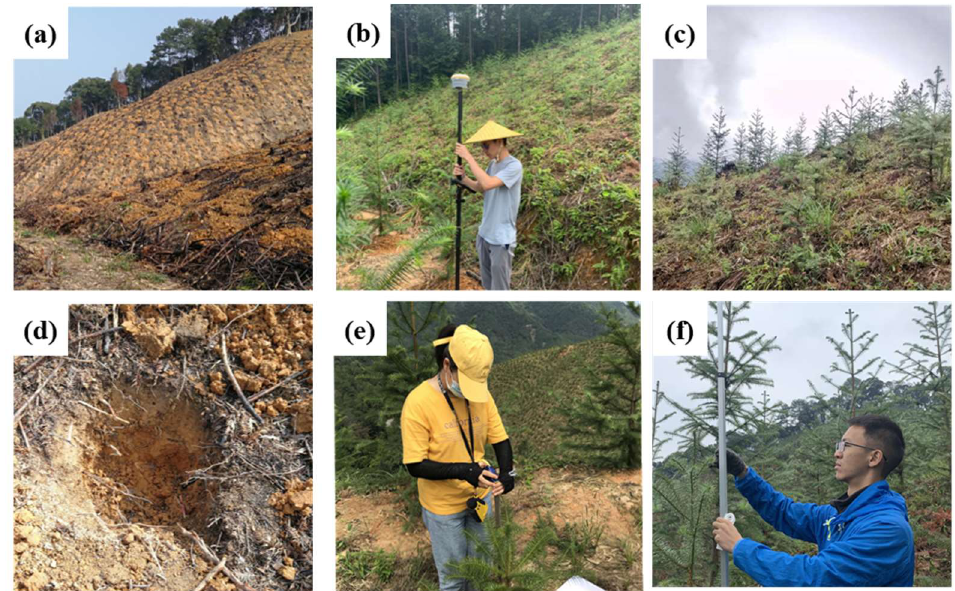
Figure 2. Field measurements of the scene. ( a – c ) shows the scenes of the test region in 2019, 2020, and 2021, ( d ) is the tree pit before afforestation in 2019, and ( e , f ) is the field scenes for tree height measurement in 2020 and 2021.